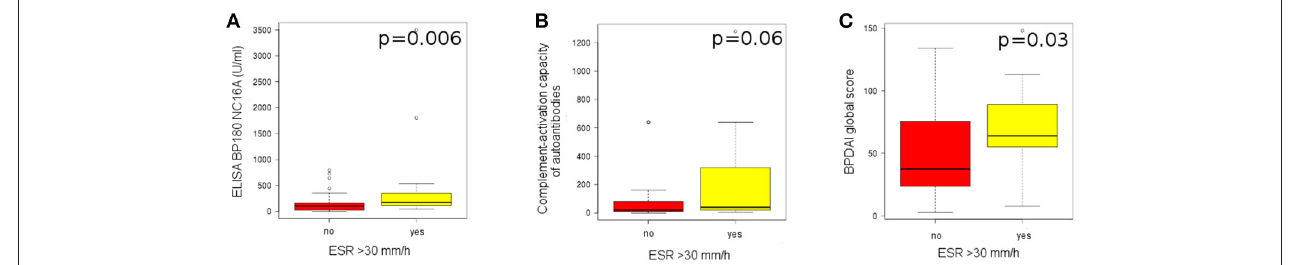
FIGURE 6 | High pemphigoid disease activity associates with increased systemic inflammatory status. (A) Level of anti-BP180 autoantibodies, measured by ELISA, in patients with an ESR > 30 mm/h ( n = 18), compared with patients with an ESR < 30 mm/h ( n = 55). (B) Level of complement activation by IgG autoantibodies, measured by complement-binding test, in patients with an ESR > 30 mm/h ( n = 18), compared with patients with an ESR < 30 mm/h ( n = 55). (C) Level of BPDAI global score, in patients with an ESR > 30 mm/h ( n = 13), compared with patients with an ESR < 30 mm/h ( n = 48). quantifying fluorescence in patients with a positive complement- binding test ( n = 26), for both Fluorescence difference ( r = − 0.21 (95% CI − 0.51 to 0.25), p = 0.315) and Fluorescence ratio ( r = − 0.2 (95% CI − 0.45 to 0.08), p =